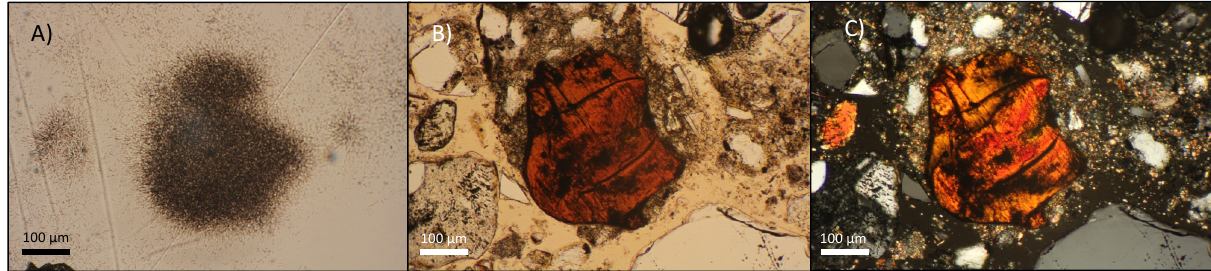
Figure 7. Fission-track and microscope images of a portion of sample GJAST-20-10 (Figure 2) at 10 × magnification with high fission-track density in a distinct mineral grain. ( A ) Fission-track image. ( B ) The same portion of the thin section in plain light. ( B ) In crossed Nicols prisms.